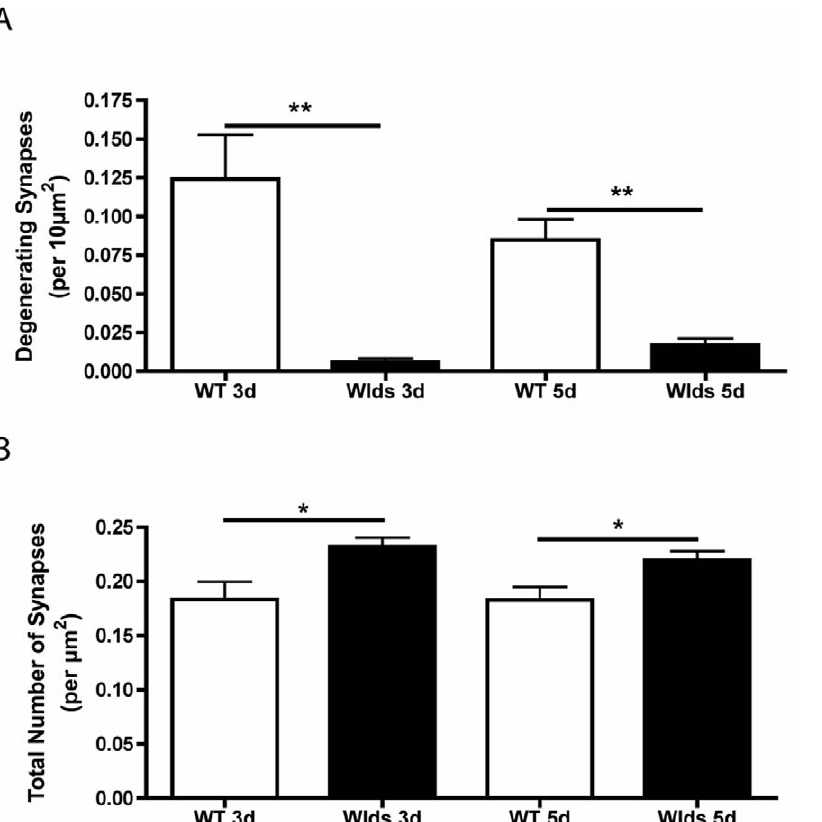
Figure 6. Quantitative analysis of synaptic degeneration confirmed robust protection of striatal synapses in old ( , 12 mth) Wld S mice 3 and 5 days after cortical lesion. A – Bar chart (mean 6 SEM) showing the number of degenerating synapses in the striatum of wild-type (WT) and homozygous Wld S (Wlds) mice at 3 and 5 days after cortical lesion (**P , 0.01, ANOVA with Tukey’s post-hoc test; N=4 wild-type mice per time-point, 3 homozygous Wld S mice per time-point). B – Bar chart showing the total number of synapses remaining in the striatum of wild-type and homozygous Wld S mice at 3 and 5 days after cortical lesion (*P , 0.05, nsP . 0.05, ANOVA with Tukey’s post-hoc test; N=4 wild-type mice per time- point, 3 homozygous Wld S mice per time-point).